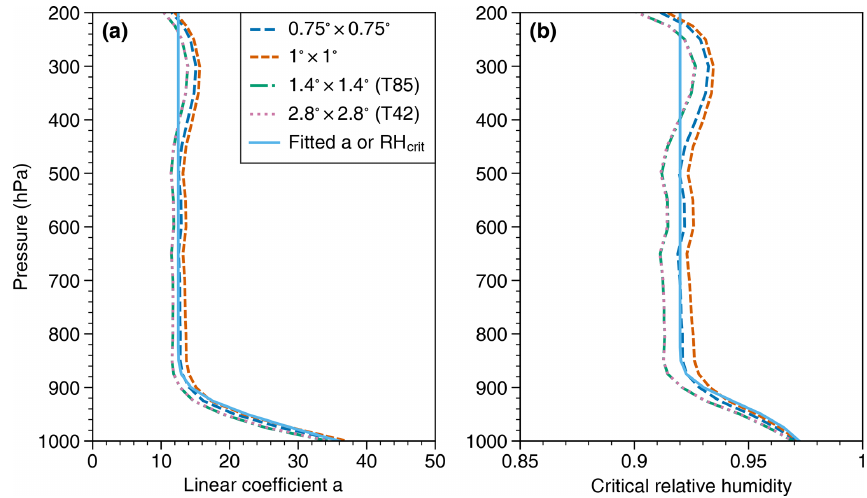
Figure 2. (a) Vertical profiles of the linear coefficient for the relative humidity-based cloud diagnostic scheme, with cloud fraction as a piecewise linear function of relative humidity as shown in Eq. (1). The dashed lines with different colors are profiles of a obtained from ERA5 data with various horizontal resolutions. The solid pale blue line denotes the fitted profile used in the model based on the form of Eq. (2). Panel (b) is the same as (a) but for the critical relative humidity ( H c ) profiles.